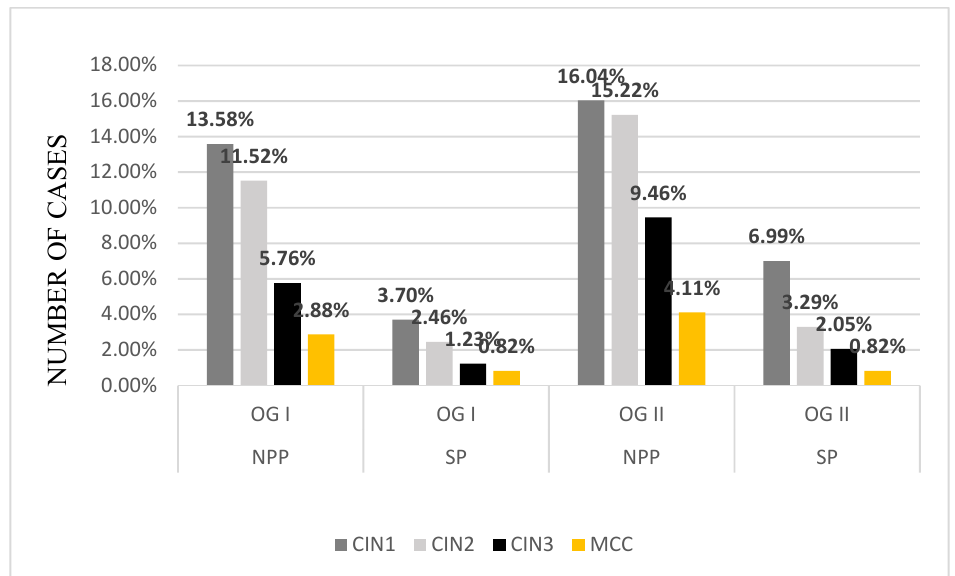
Figure 11. The rate of dysplastic lesions diagnosed using histopathological examination: the year before the pandemic and the first year of the SARS-CoV-2 pandemic. OG: Obstetrics and Gynecology Clinic; CIN: cervical intraepithelial neoplasia; MCC: microinvasive cervical cancer; NPP: non-pandemic period; SP: first year of SARS-CoV-2 pandemic.